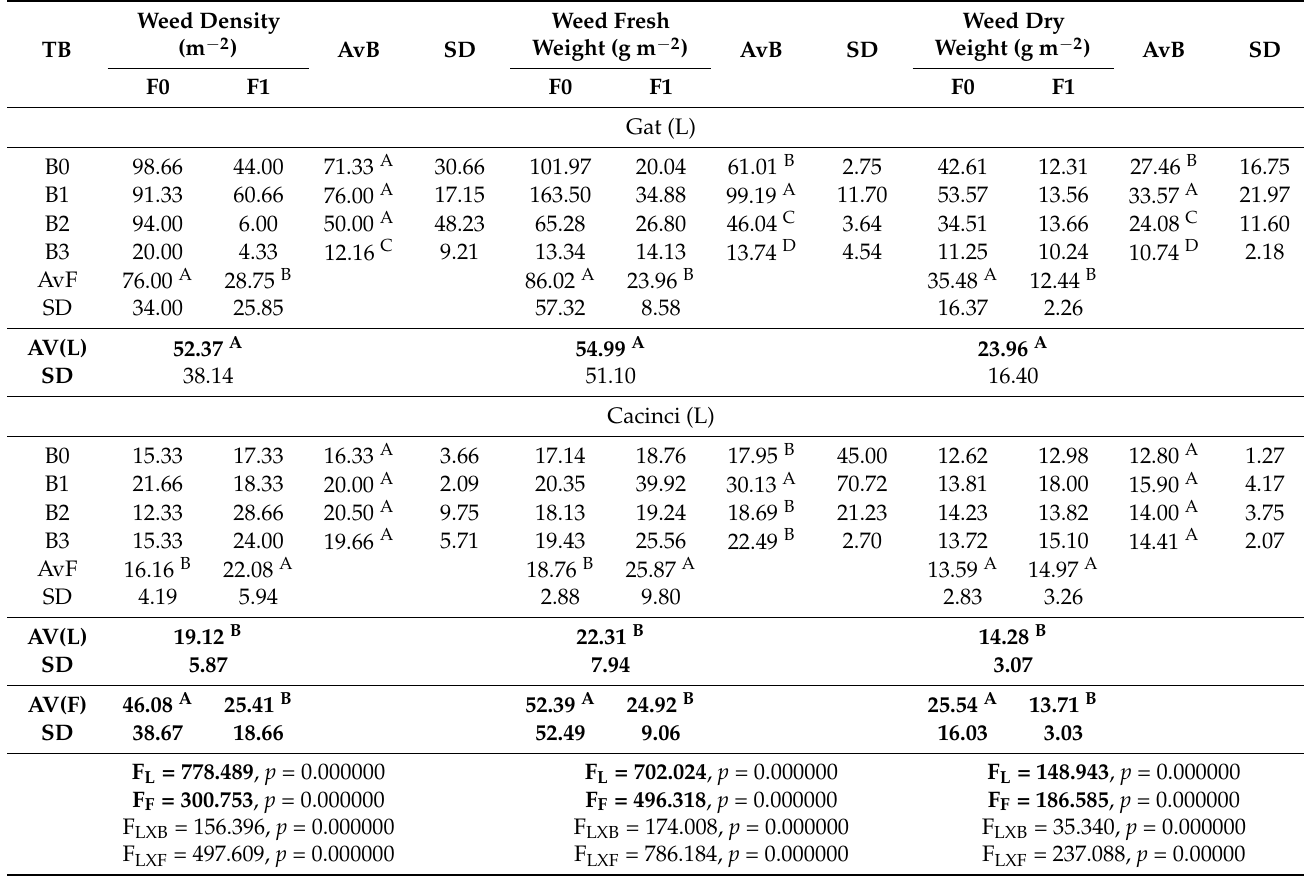
Table 5. Biochar and fertilization effects on weed density, weed fresh and weed dry weight at two locations at the end of the winter wheat tillering